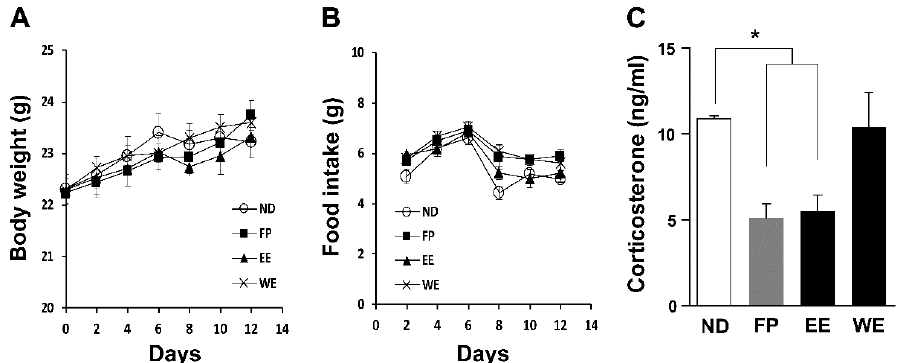
Figure 1. A spinach extract diet reduced blood CORT level. ( A ) Body weight and ( B ) food intake ( n = 8 mice per group). ( C ) Blood CORT decreased in mice fed an FP and EE diet but not a WE diet ( n = 5 mice per group). All values are means ± SEM. * p < 0.05. EE, ethanol extract; FP, frozen powder; ND, normal diet; WE, water extract; CORT, corticosterone.